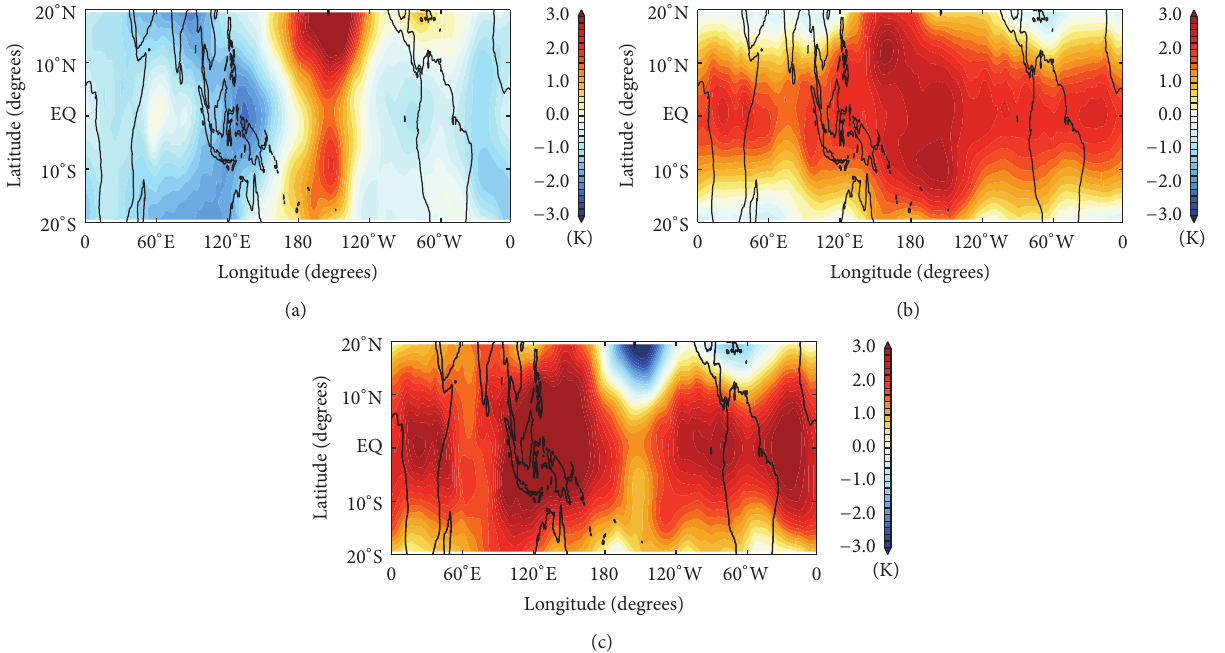
Figure 2: The spatial distributions of CPTT anomalies during the (a) “prewarming” and (b) “postwarming” periods in 1999. CPTT anomalies are calculated by subtracting the CPTT daily climatology based on the period from 1994 to 2005 from the daily CPTT values in 1999. (c) CPTT differences between the “postwarming” and “prewarming”